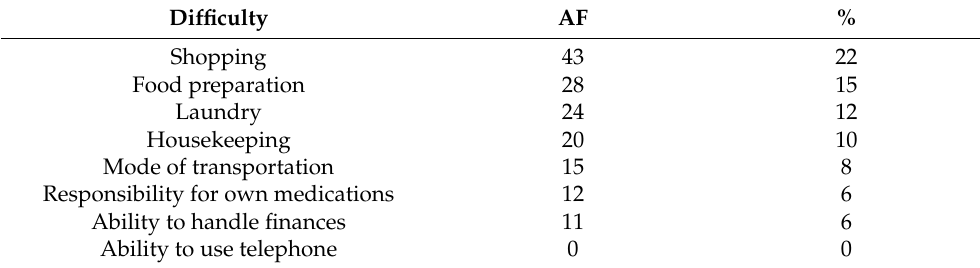
Table 2. Difficulties in IADL (Instrumental Activities of Daily Living) in order of